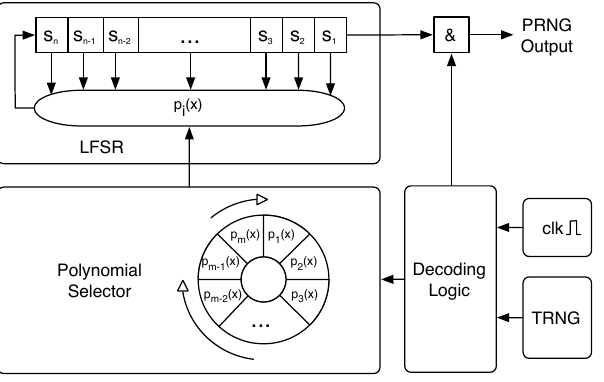
Figure 1. Block diagram of